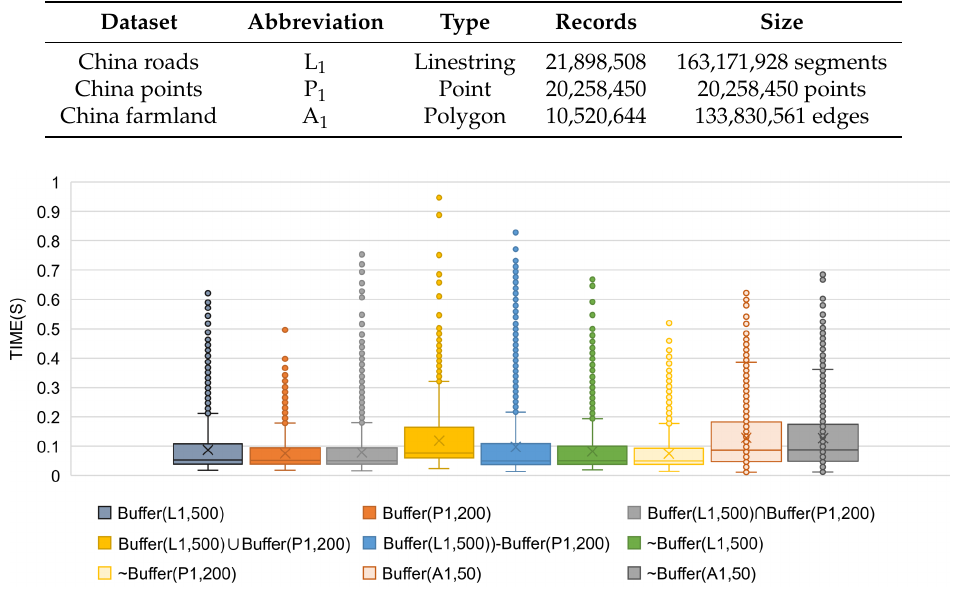
Figure 10. Tile rendering time